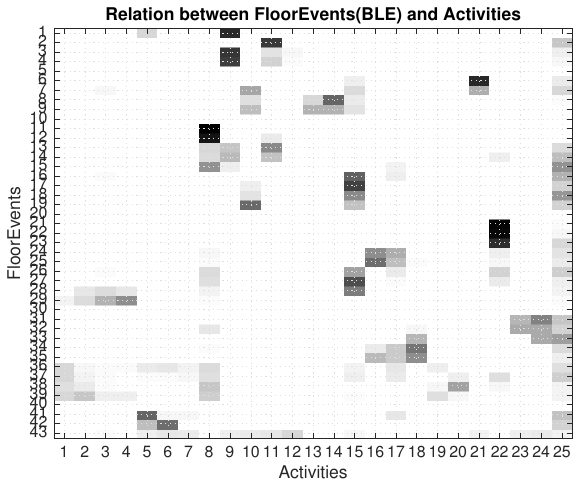
Figure 6. Measurement matrix relating floor events with activities (for seven-days training set).